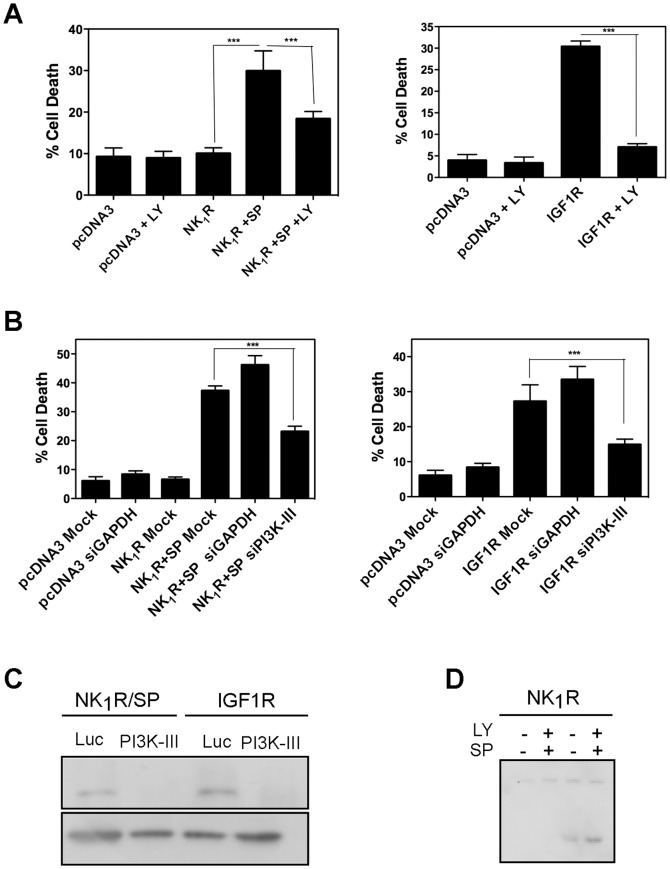
PI3K-III activity is necessary for NR4A1-mediated vesicular cell death.HEK293 cells were transfected with either the empty vector pcDNA3, NK1R and exposed or not to SP, or IGF1R as indicated. A, Pharmacological inhibition of PI3K with LY294002 reduces cell death. DMSO was added as vehicle control. B, Specific down regulation by RNAi of PI3K-III inhibits cell death. HEK293 cells were transfected with the indicated siRNAs. Cells death was determined by trypan blue exclusion 24 hr after induction. Bars represent standard error. ***, p<0.001, n = 4. C, Western blot to show the efficiency of RNAi. Luc refer to siRNAs targeting the luciferase gene, as irrelevant siRNA. GAPDH was detected as loading reference. D, induction of NR4A1 expression upon cell death activation is upstream of autophagy activation. HEK293 cells were transfected with NK1R expression vector and exposed or not SP, and the expression of NR4A1 was monitored by Western blot in the presence or absence of the autophagy inhibitor LY294002, as indicated.